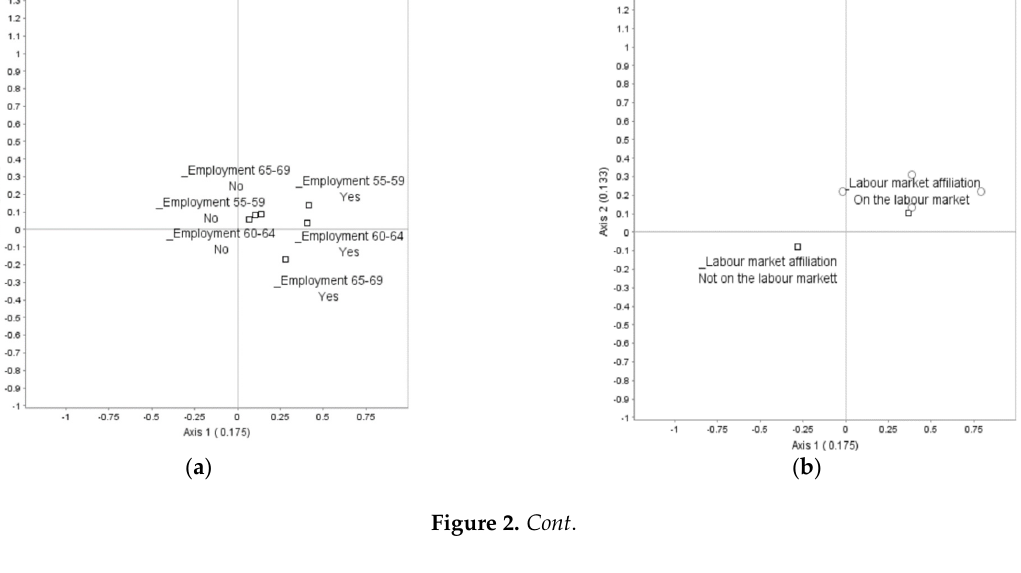
Table 3. Interpretation of Axis 2; 6 response categories contributing above-average to axis variance, 2 additional categories contributing below-average added in brackets. Ctr. of variables and categories are in percent.